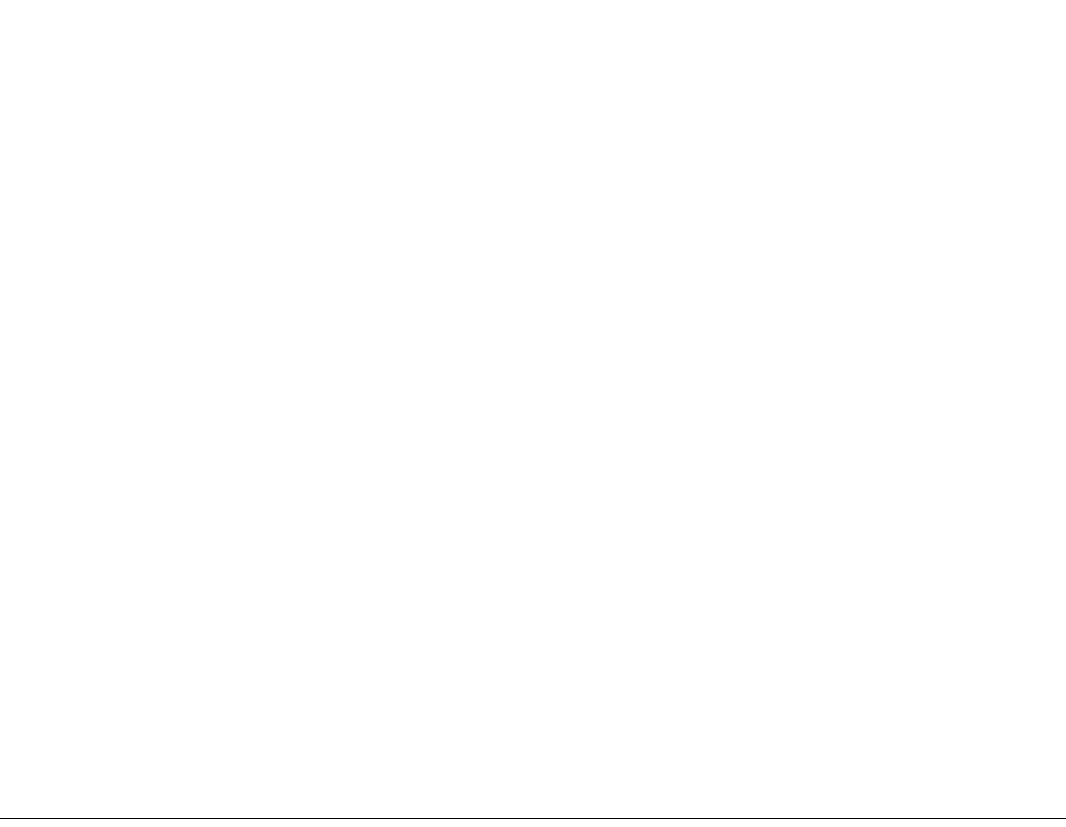
sup-2 Acta Cryst. (2008). E 64 , i3